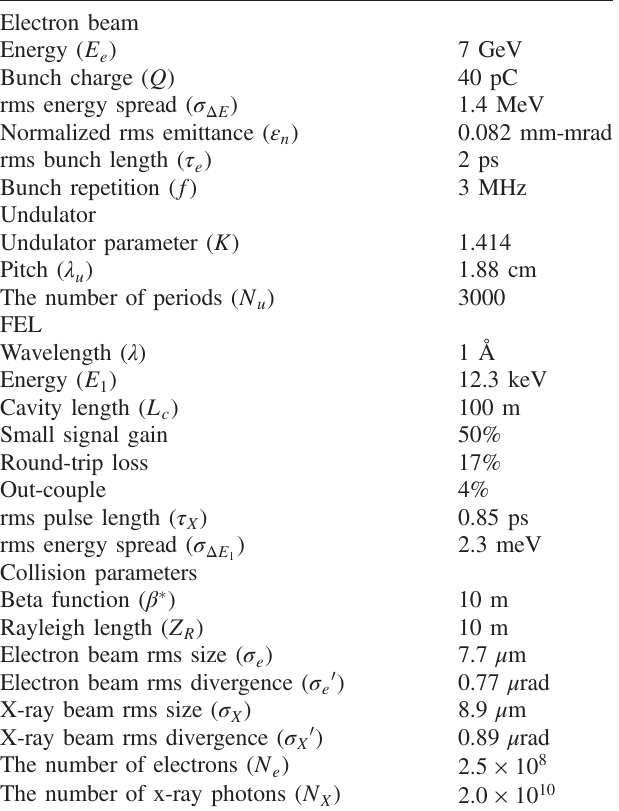
and incident and scattered photons, θ is the angle between the incident and scattered photons.